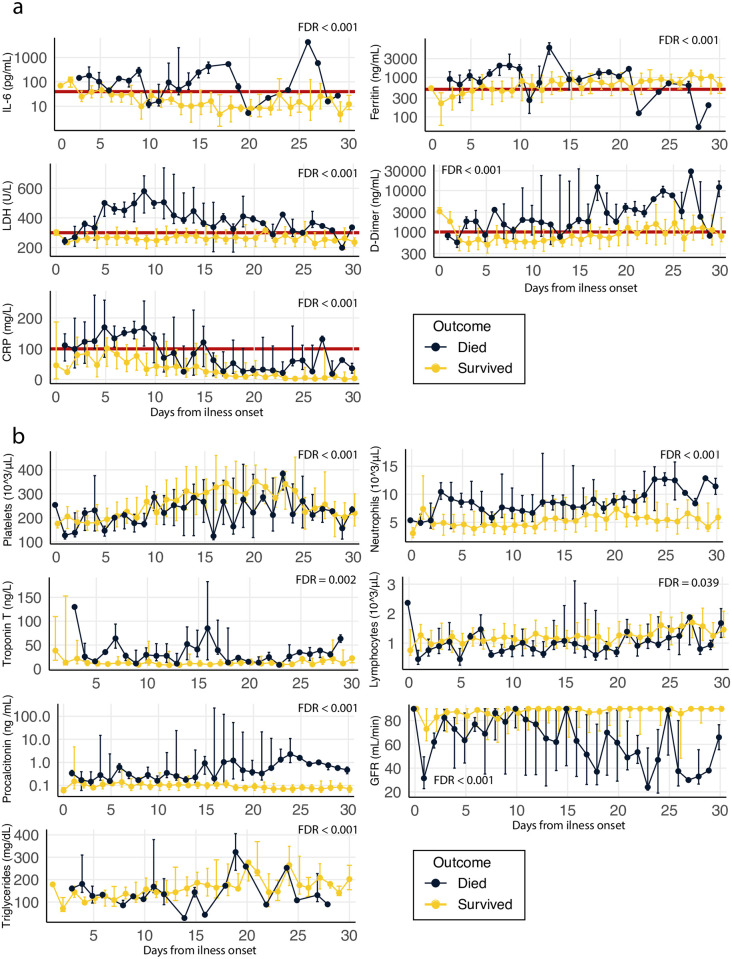
Time course analysis of survivors/non-survivors all laboratory tests carried out during the first month from COVID-19 illness onset.Median and interquartile range are presented in each timepoint. The data is showed in a linear scale except in the case of IL-6, ferritin, D-dimer and procalcitonin, which are shown in a Log10 scale (see S1 Table for the measurement unit of all markers and rest of the time course analyses). The false discovery rate (FDR) of the overall time-differences is shown for each marker (see the results of all the tests carried out in S1 Table). a. Inflammatory markers: IL-6, Ferritin, Lactate dehydrogenase (LDH), D-dimer and C-reactive protein (CRP). Marked with a red line are suggestive cut-offs that could potentially be used to select patients at risk of developing a hyper-inflammatory response IL-6 > = 40 pg/ml, C-reactive protein > = 100 mg/L, D-dimer > = 1000 ng/ml, ferritin > = 500 ng/ml and lactate dehydrogenase > = 300 U/L). b. Other clinically relevant markers: platelets, total neutrophils, troponin T, total lymphocytes, procalcitonin, glomerular filtration rate (GFR) and triglycerides.